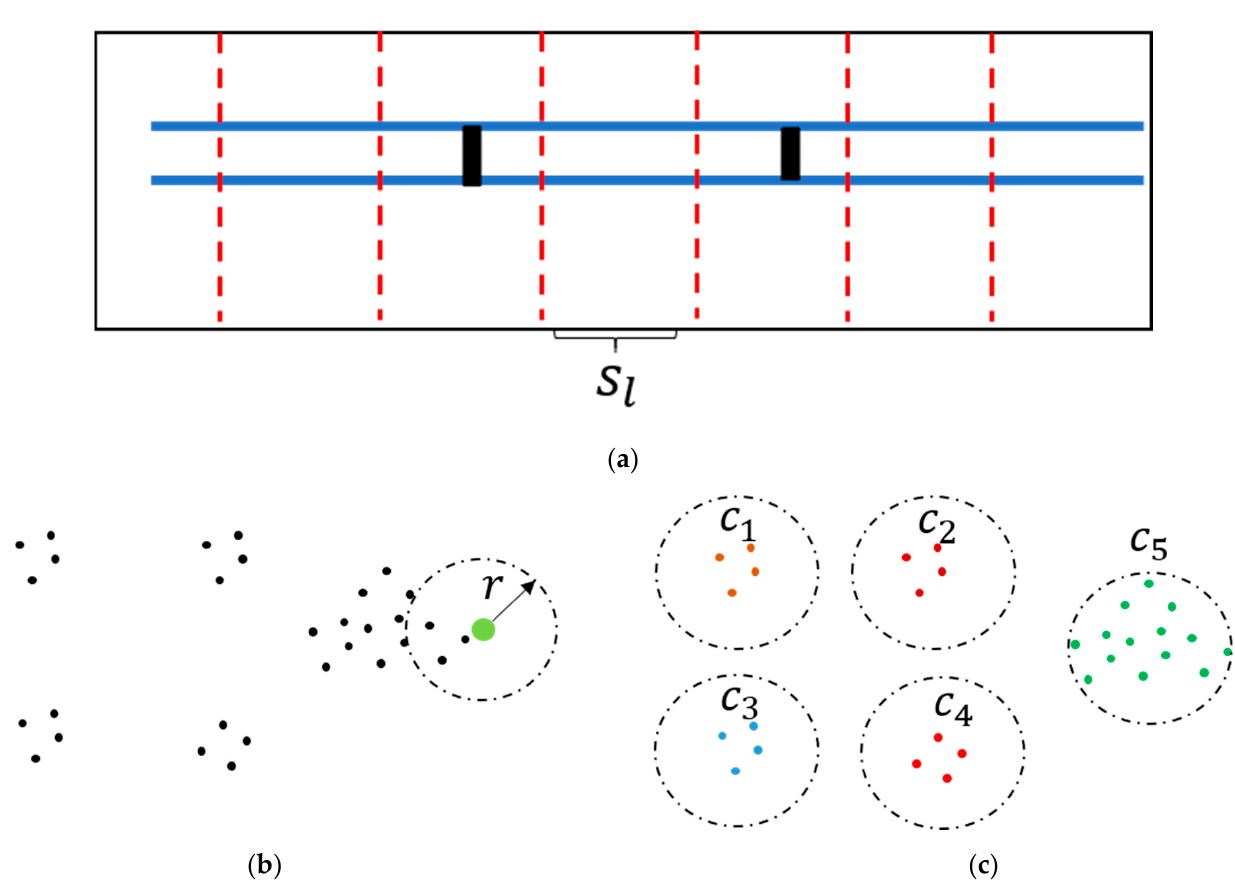
Figure 6. Segmentation and Euclidean Clustering (EC). ( a ) Segmentation of preprocessed data with predefined step length s 1 . Blue lines represent powerlines and black lines represent pylons. ( b , c ) The schematic diagram of EC within a segment (cross–section).